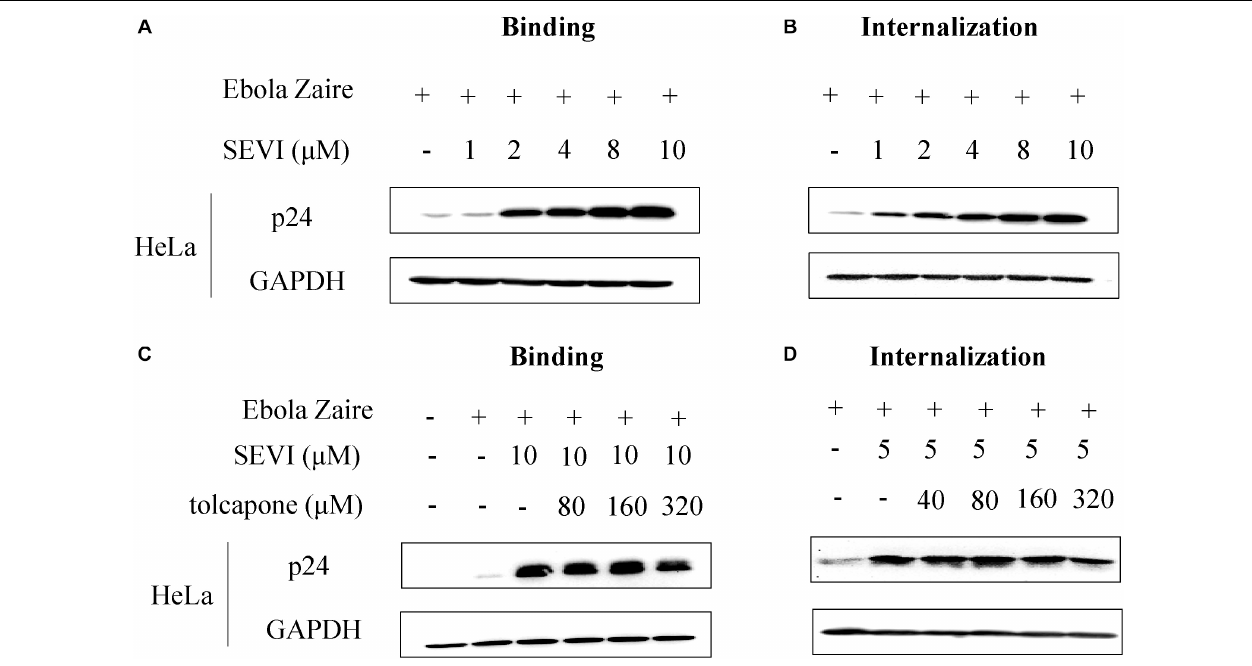
FIGURE 6 | Tolcapone inhibits semen-derived enhancer of viral infection (SEVI)-induced enhancement of binding and internalization of Zaire-pseudovirus (PsV) to HeLa cells. Zaire-PsV was incubated with SEVI (A,B) or tolcapone-treated SEVI (C,D) then bound to HeLa cells on ice. Cells were either lysed in 1% Triton for 10 min on ice after 1 h (binding) (A,C) or warmed to 37 ◦ C for 1 h to allow viral internalization, washed with phosphate buffered saline (PBS), trypsinized, and lysed with 1% Triton (internalization) (B,D) . Lysates were used for determination of the level of p24 by Western blotting.